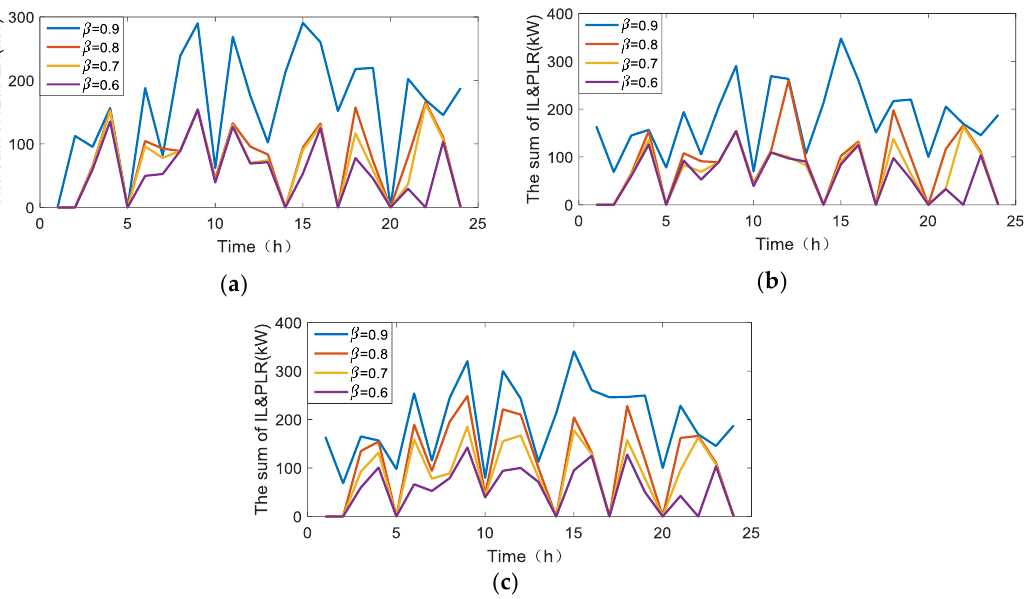
Figure 4. The output in each intraday credibility scenario: ( a ) Γ = 1; ( b ) Γ = 3; ( c ) Γ =